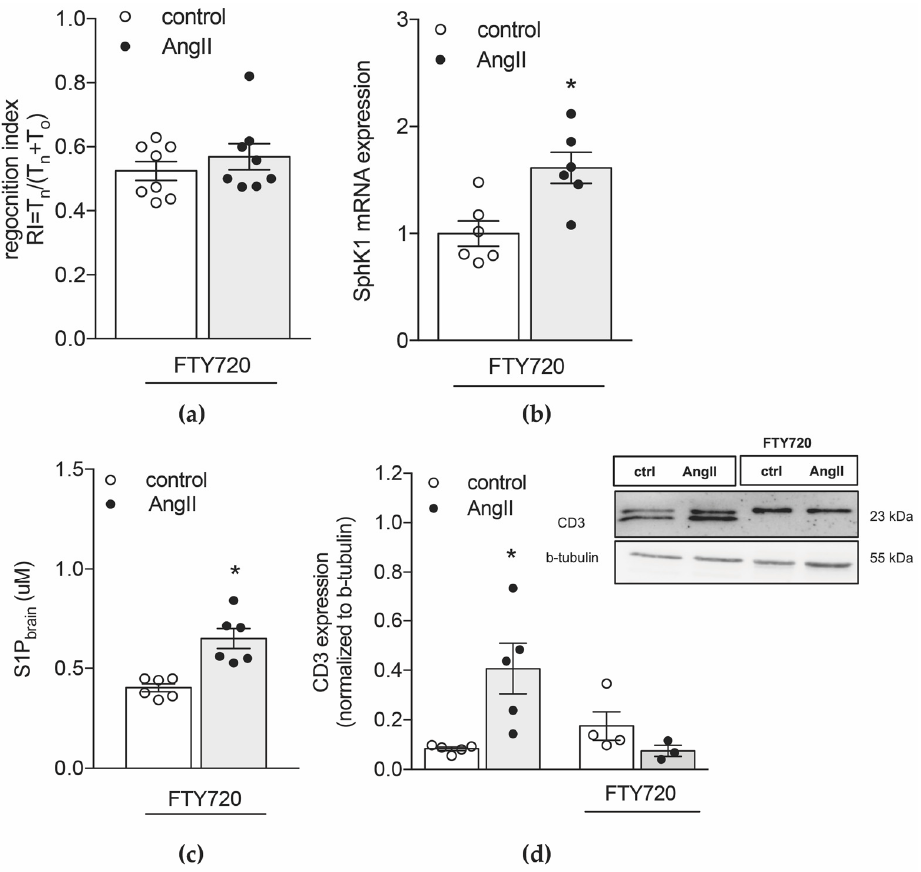
Figure 3. Inhibiting S1P chemotaxis protects from hypertension-associated cognitive impairment. ( a ) Memory function was assessed in a novel object recognition task with 24 h delay interval in mice treated with 1mg/kg BW FTY720 for two constitutive weeks. ( b ) qPCR analysis of sphk1 mRNA expression in normotensive and hypertensive mice treated with 1mg/kg BW FTY720. ( c ) Mass spectrometry analysis of S1P levels in the brain of normotensive and hypertensive WT mice treated with FTY720. ( d ) Western blot analysis of brain CD3 protein expression in normotensive and hypertensive WT mice with or without FTY720 treatment. Data expressed as mean ± SEM; n = 6–8 per group * p < 0.05 after single unpaired comparisons. Table 2. Number of circulating S1P 1 + CD3+ T-cells. Flow cytometry-based assessment of circulating S1P 1 + CD3+ T-cell numbers in blood samples of WT, SphK1 − / − and FTY720-treated WT mice after chronic AngII or saline perfusion. Data expressed as mean ± SEM; n = 10 for WT and n = 6 for SphK1 − / − and FTY20-treated WT groups; * p < 0.05 after single unpaired comparisons.